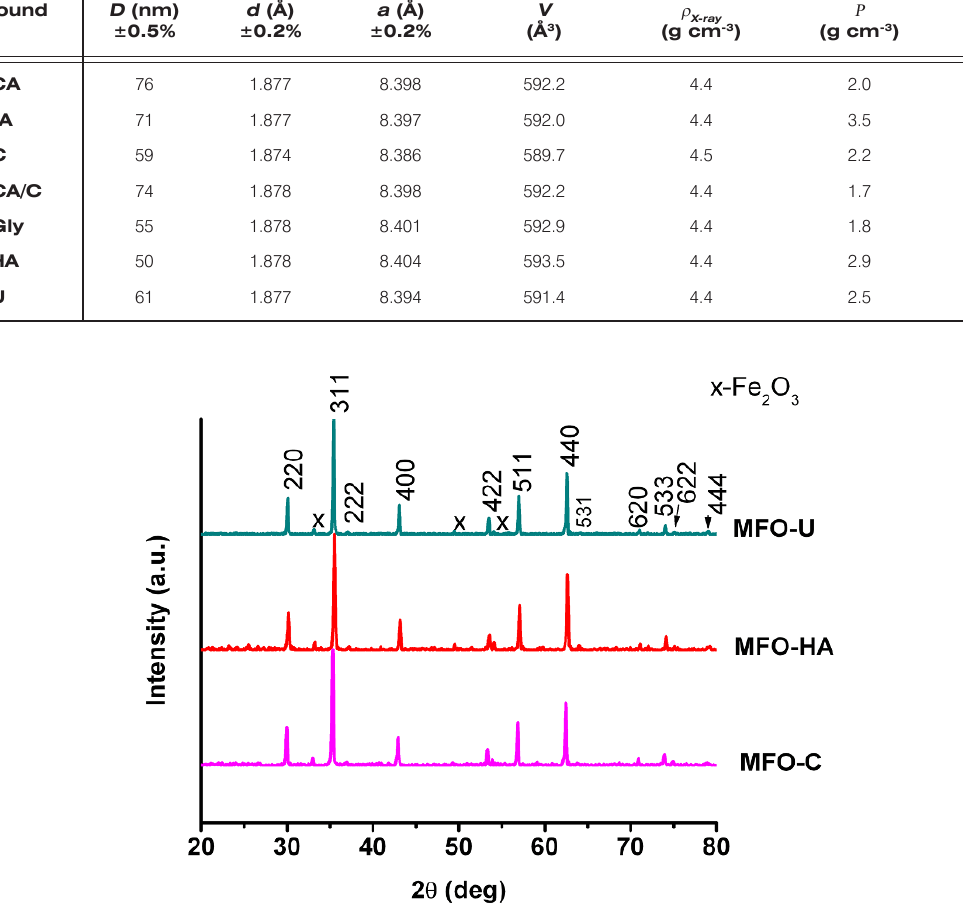
Table 3. Crystallite size ( D ), interplanar distance ( d ), lattice parameter ( a ), unit cell volume ( V ), X-ray density ( ρ ( P ) of magnesium ferrite powders heat treated at 1173K, from X-ray diffraction patterns. Compound